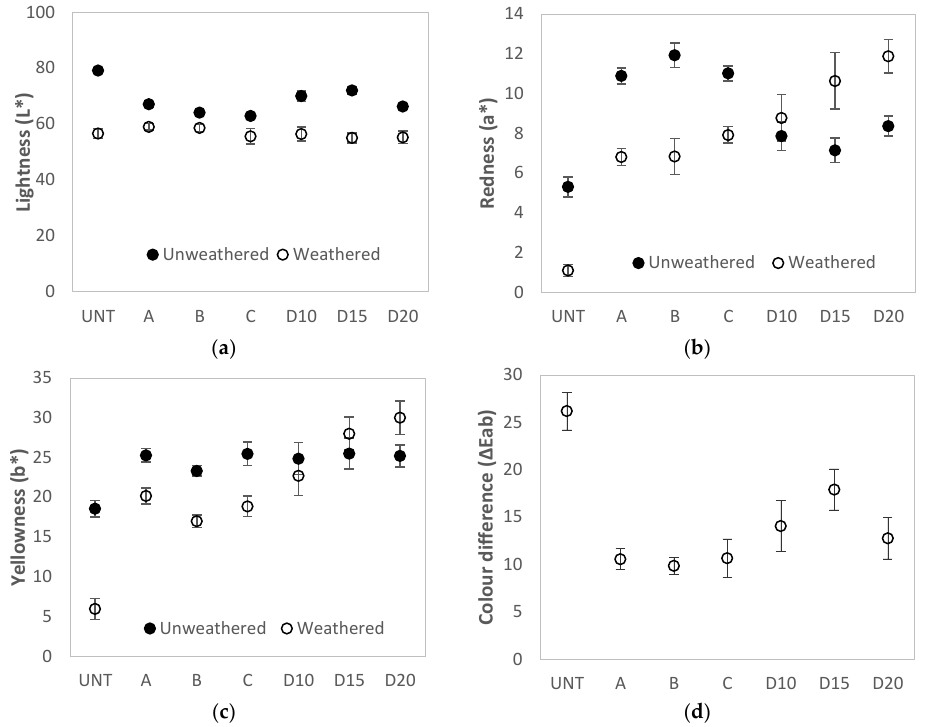
Figure 3. Changes in colour of untreated (UNT) and PF resin treated plywood after exposure to outdoor conditions for 3 months: ( a ) Changes in the CIE parameter L* (lightness); ( b ) Changes in the CIE parameter a* (red-green); ( c ) Changes in the CIE parameter b* (yellow-blue); ( d ) Colour difference parameter ΔEab.